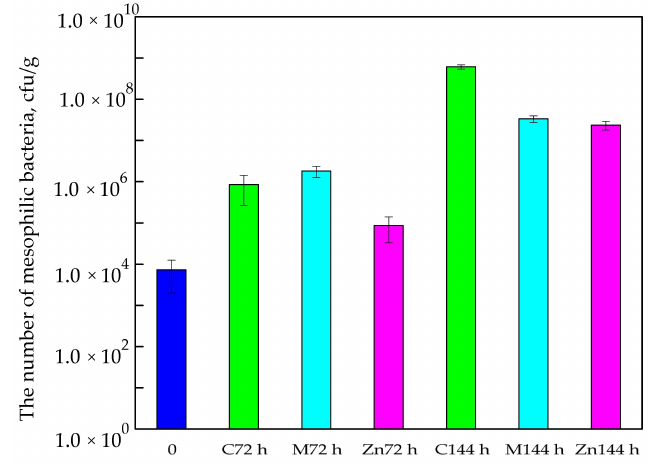
Figure 2. The number mesophilic bacteria after 72 h and 144 h of